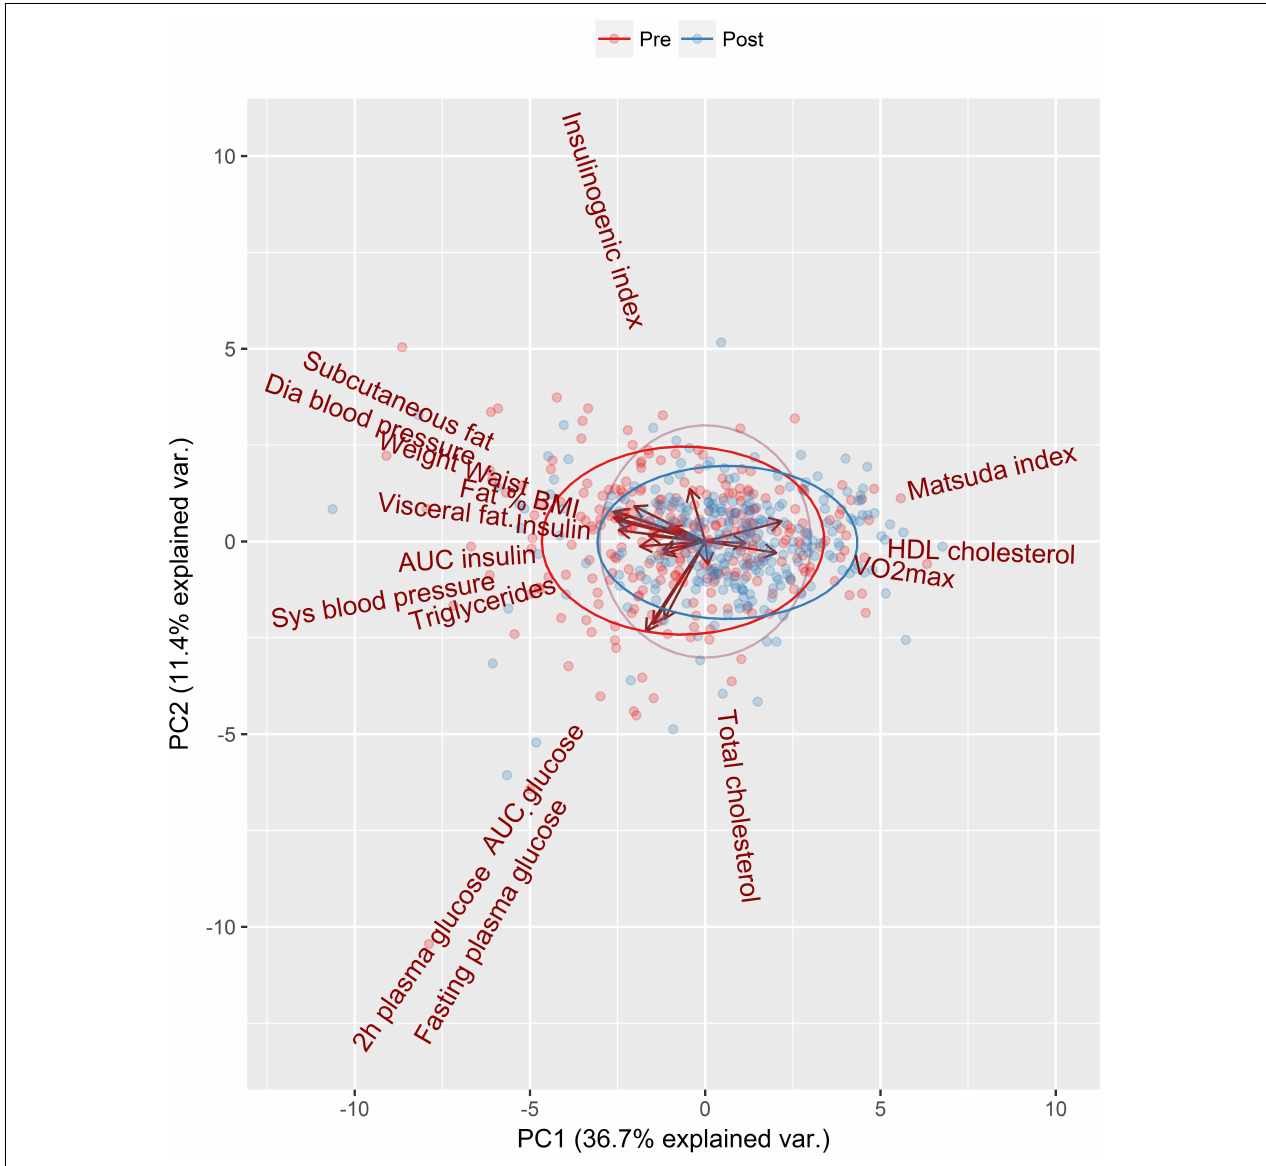
FIGURE 2 | The first two principal components of the data, showing a multivariate change over the 12 weeks intervention. The first and second principal components (PC1 and PC2) are shown on the x-axis and y-axis, respectively. The loadings of the variables are shown with arrows, and the scores of the participants are shown as dots in the background with red (pre) and blue (post-intervention). Arrows pointing to the right (on the x-axis) and upwards (on the y-axis) illustrate a positive change score, e.g., Matsuda index and VO 2 max (l/min). Arrows pointing to the left (on the x-axis) and downwards indicate a negative change